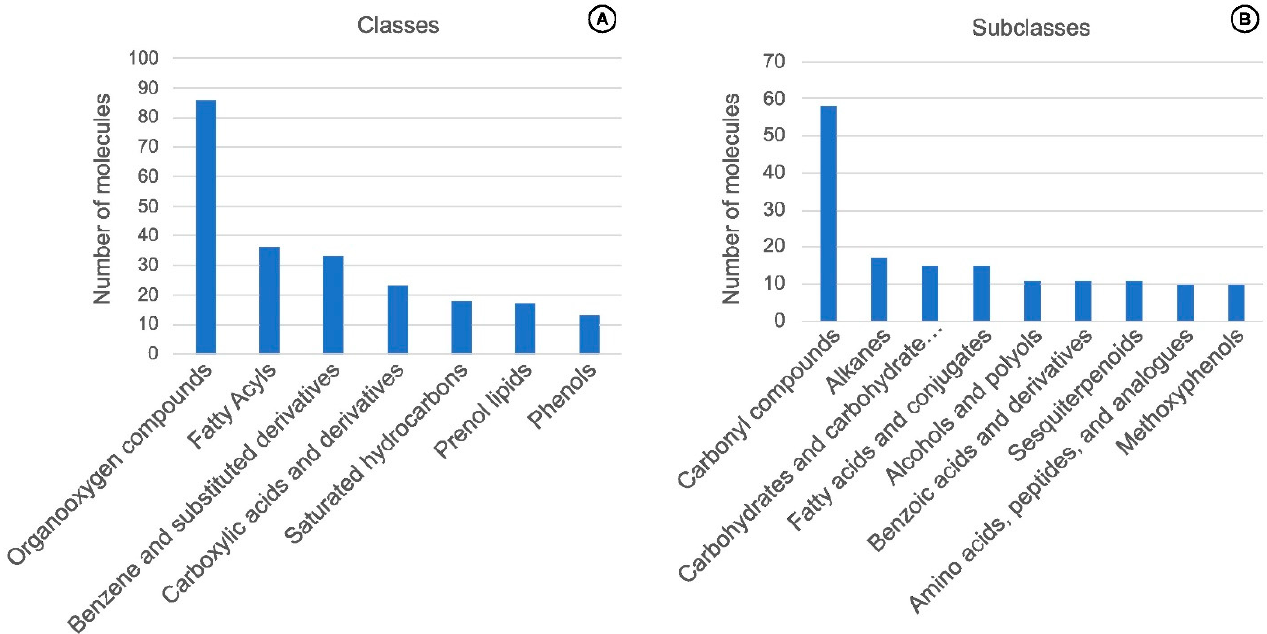
Figure 5. Pool of the most frequent chemical ( A ) classes and ( B ) subclasses correlated to compounds identified in vanilla crop WR and hybrid species.